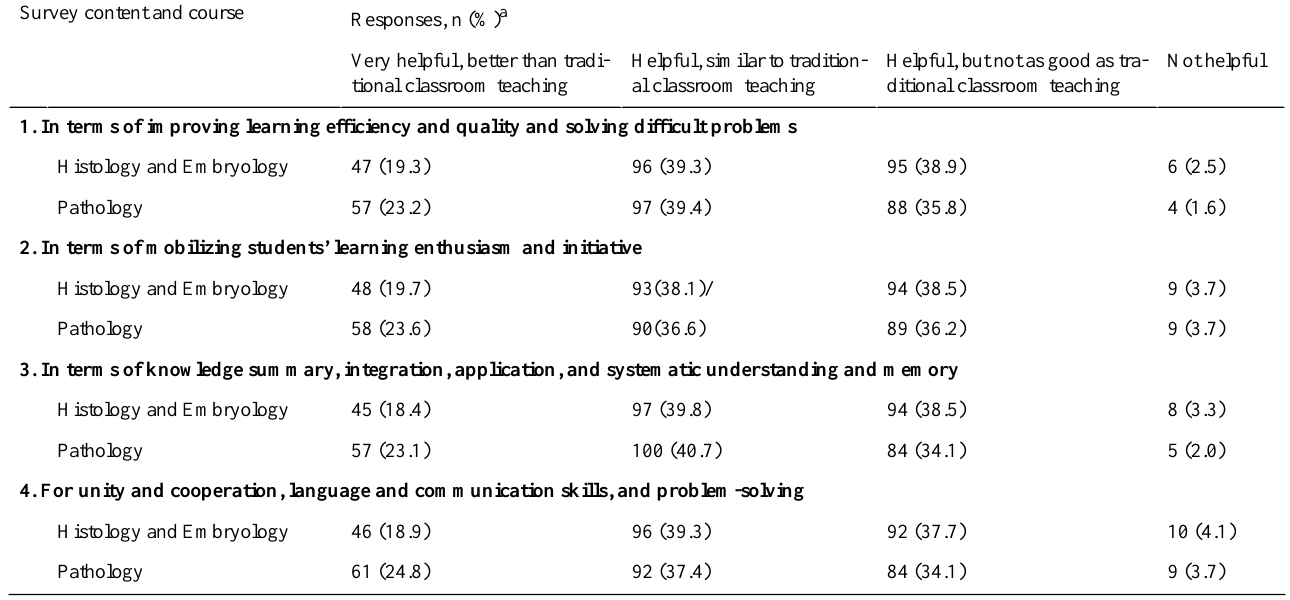
Table 2. Results of the second part of the questionnaire showing the students’satisfaction with the web-based teaching performance.